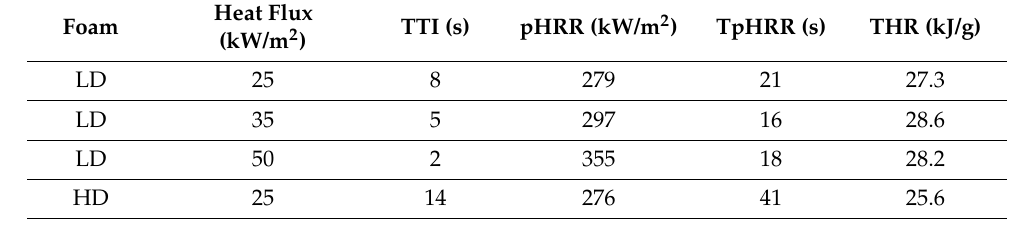
Table 3. Main data from cone calorimeter tests on 2 cm-thick foams.